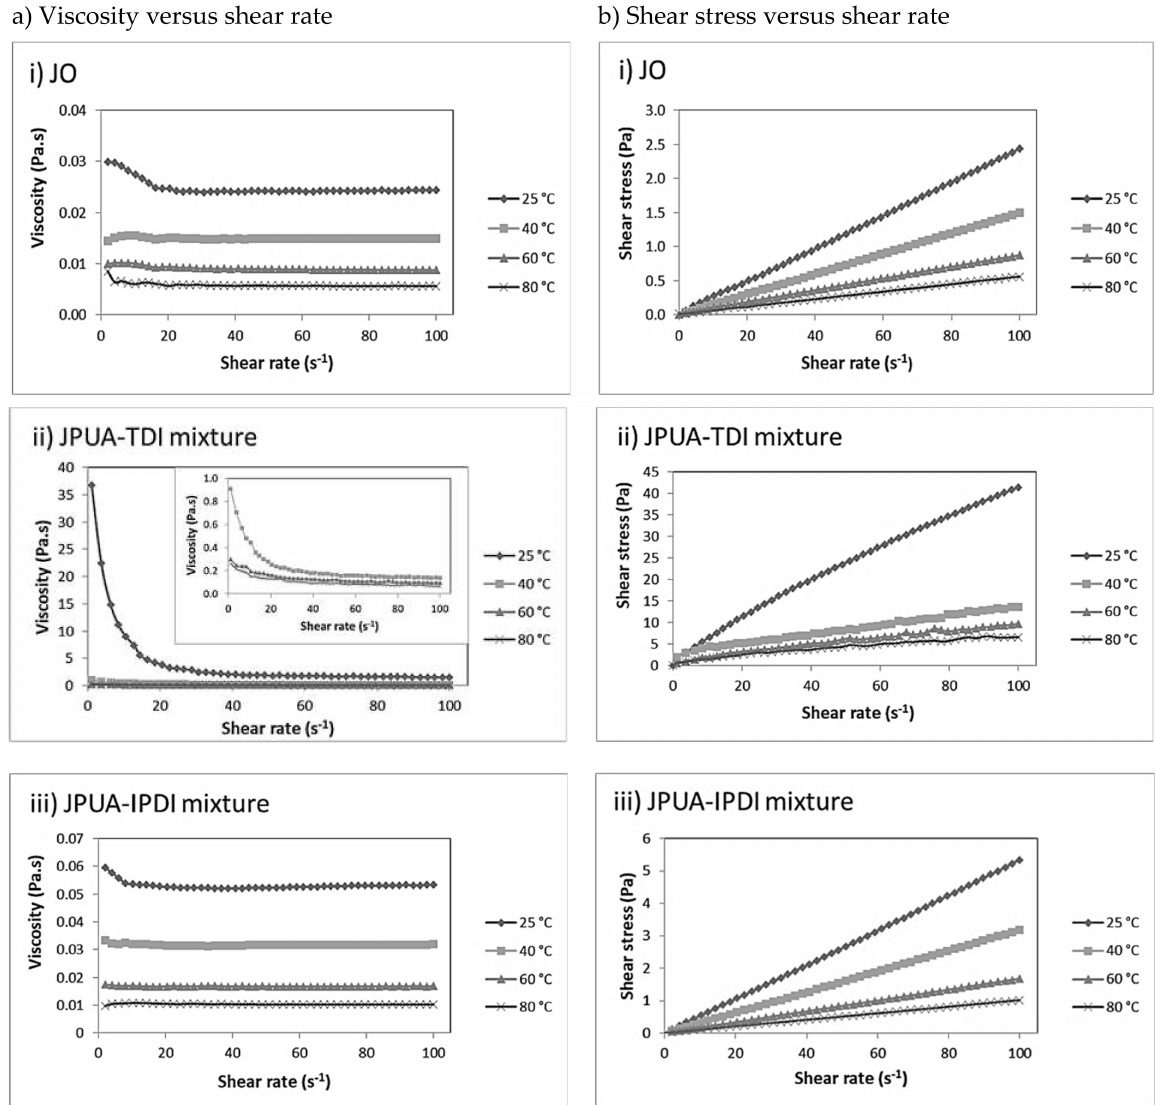
Figure 5. Trends of ( a ) viscosity and ( b ) shear stress at shear rates of 0 to 100 s − 1 measured at various temperatures. Each set of experiments were conducted on i) JO, ii) JPUA-TDI mixture and iii) JPUA-IPDI mixture